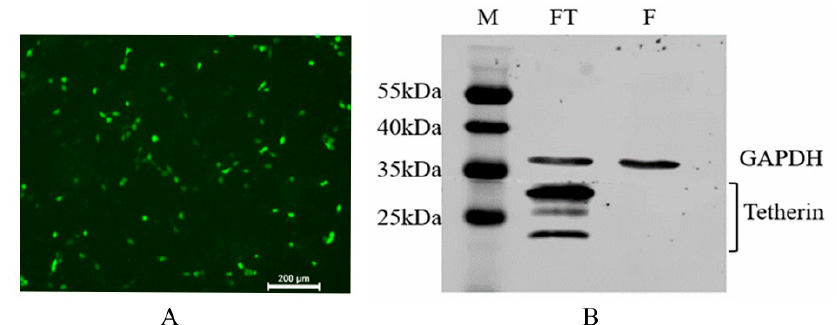
Figure 4. IFA (Immunofluorescence assay) and western blot detection of recombinant canine tetherin protein expression. ( A ) IFA results in MDCK cells; ( B ) Western blot analysis of canine tetherin protein. M: protein standard marker; FT: expression product of p3×FLAG-CMV10-Tetherin; F: expression product of the empty vector.